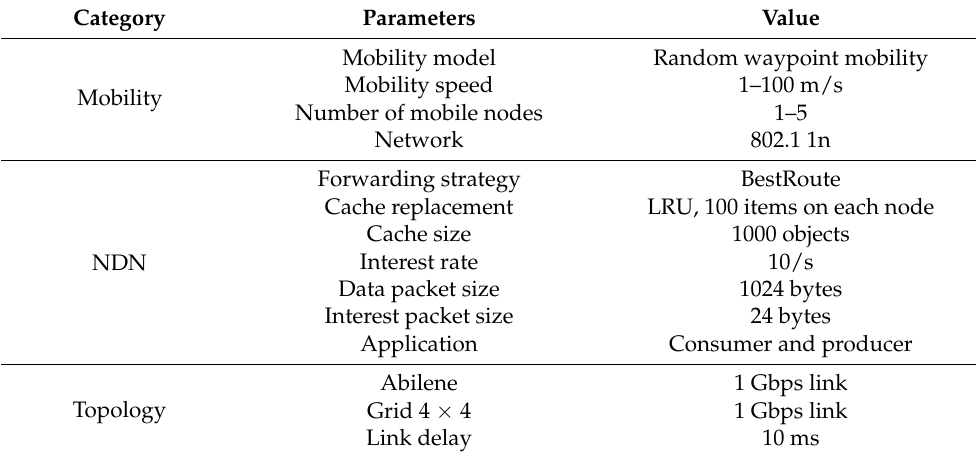
Table 2. Simulation parameters and